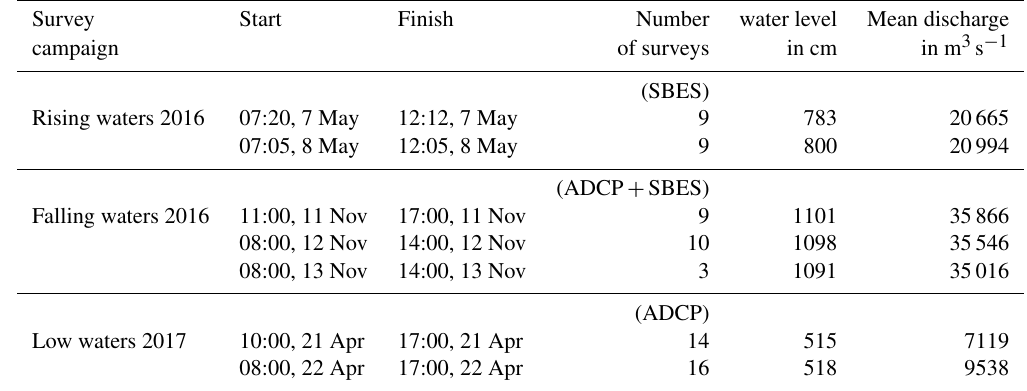
Table 1. SBES and ADCP surveys acquired on three occasions in the Orinoco River. Survey